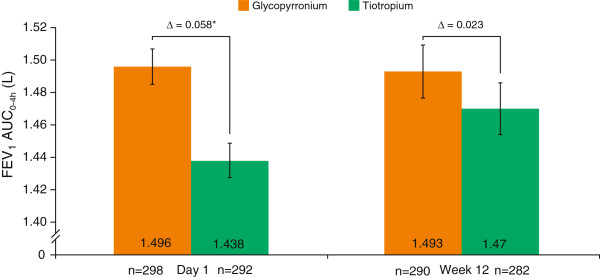
FEV1 AUC0–4h treatment differences for glycopyrronium versus tiotropium on Day 1 and at Week 12 (PPS). Data are LSM ± standard error; *p < 0.001; AUC = area under the curve; FEV1 = forced expiratory volume in 1 second; PPS = per-protocol set.